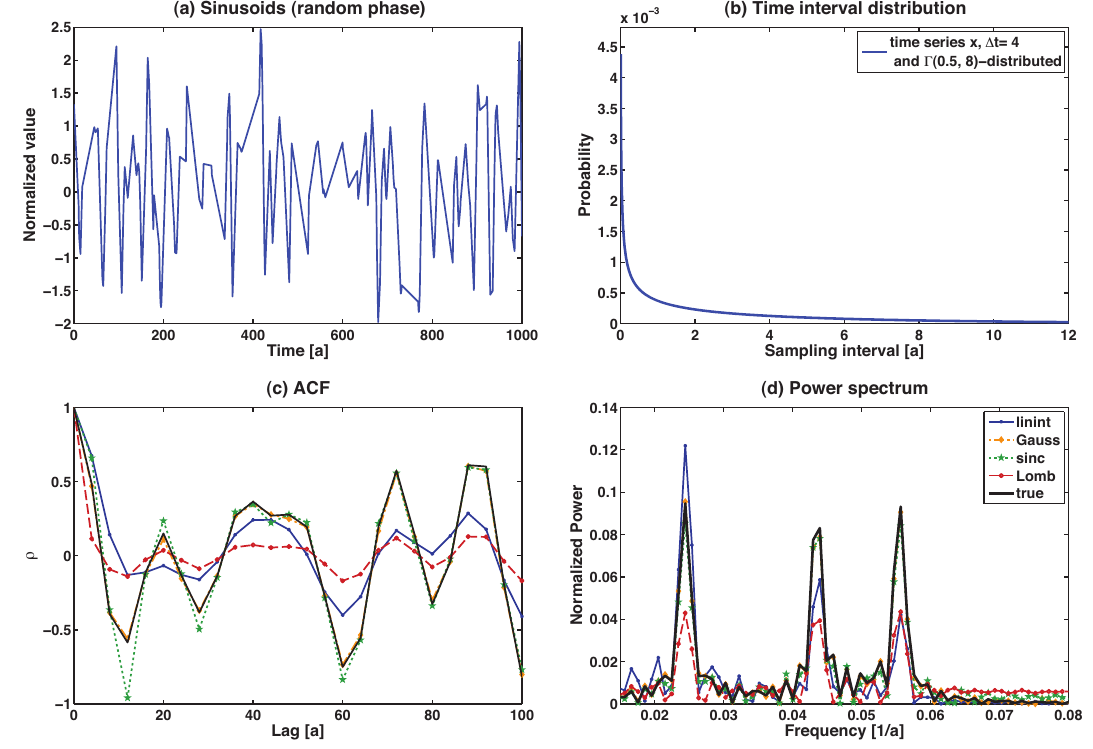
Fig. 6. Autocorrelation analysis of synthetic signals: for an irregularly sampled combination of sinusoids (cf. Eq. 14) we give a sample time series (a) , the sampling interval probability density (b) , the expected correlation function (c) and the corresponding power spectrum (d) determined from 100 realizations of sinusoid time series with random phase arguments. Legends for each row are given in the right panels. High sampling irregularity leads to a variance reduction in the ACF for LS and